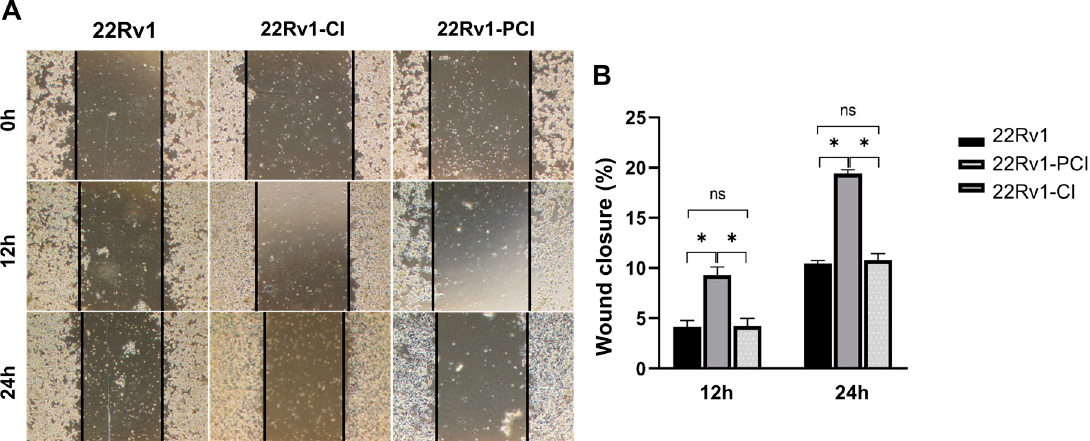
Figure 3. ( A ) Cell migration of 22Rv1-CI or 22Rv1-PCI cells compared with 22Rv1 cells. ( B ) Bar graph represents the percentage of scratch closure. Data are mean ± SEM. * p < 0.05; ns, not signifi- cant.